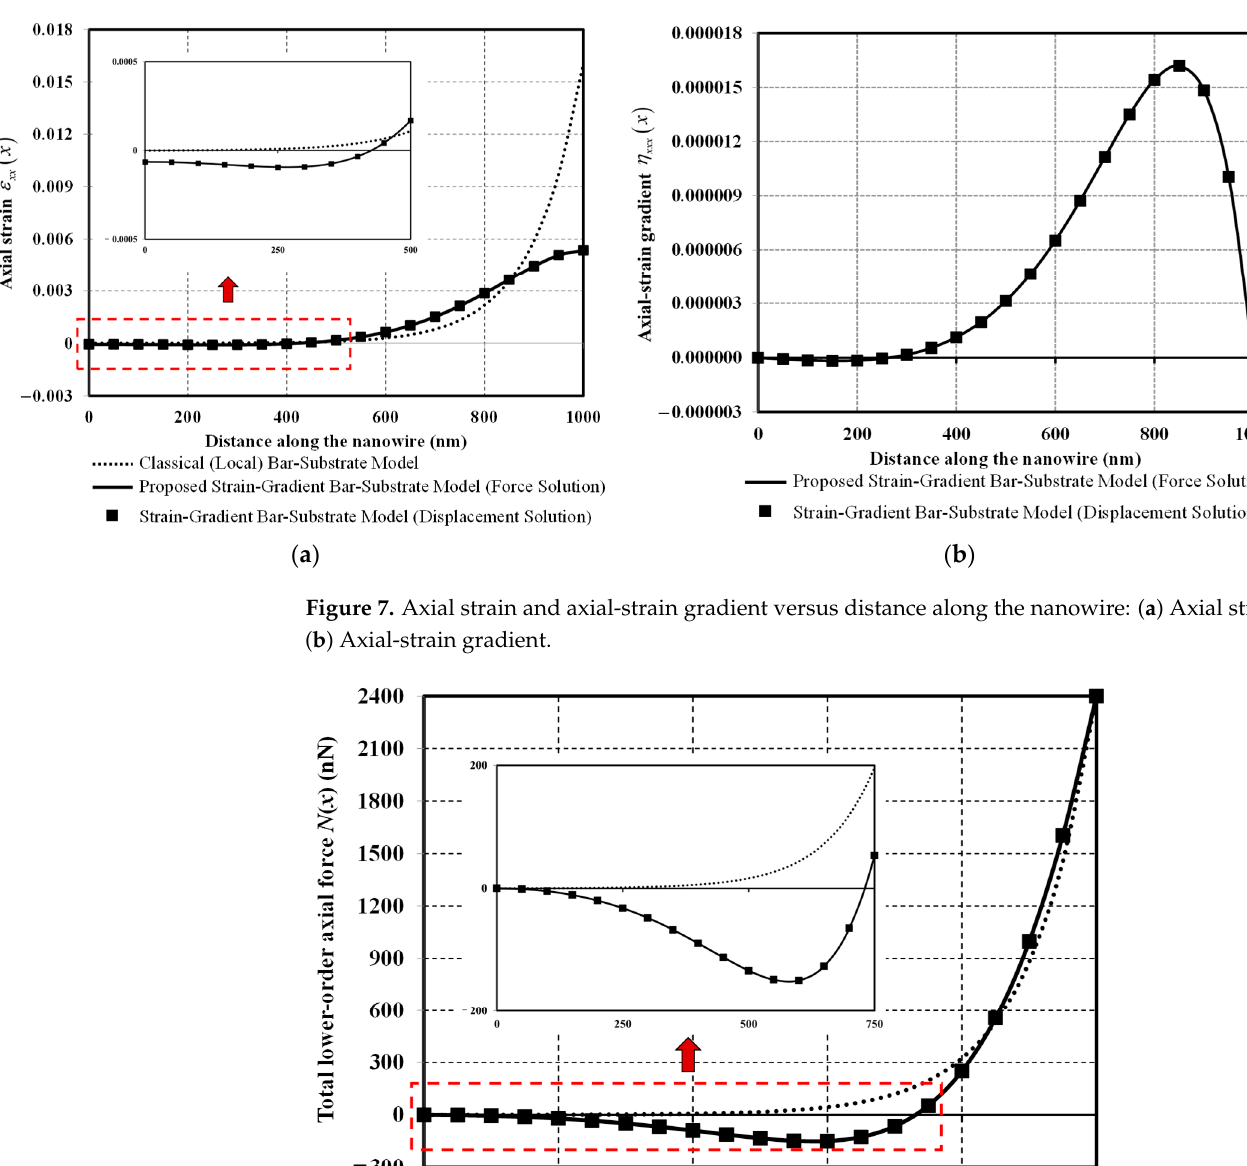
Figure 7. Axial strain and axial-strain gradient versus distance along the nanowire: ( a ) Axial strain; ( b ) Axial-strain gradient.